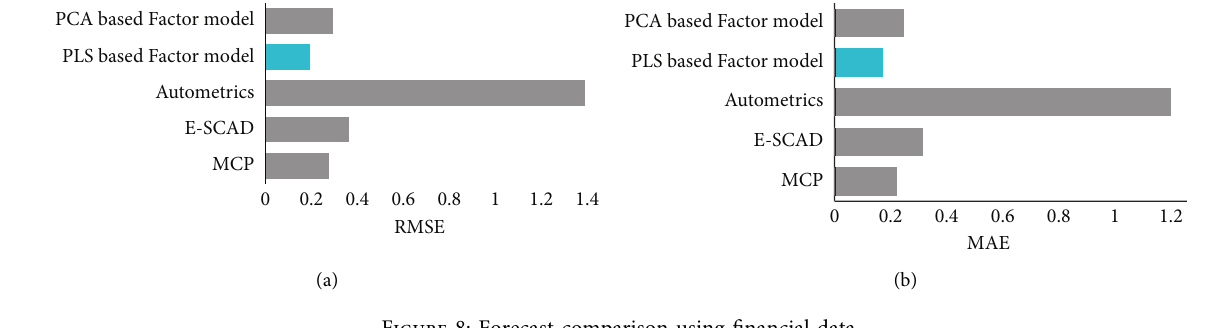
Figure 8: Forecast comparison using financial data. Table 4: Methods’ performance across various